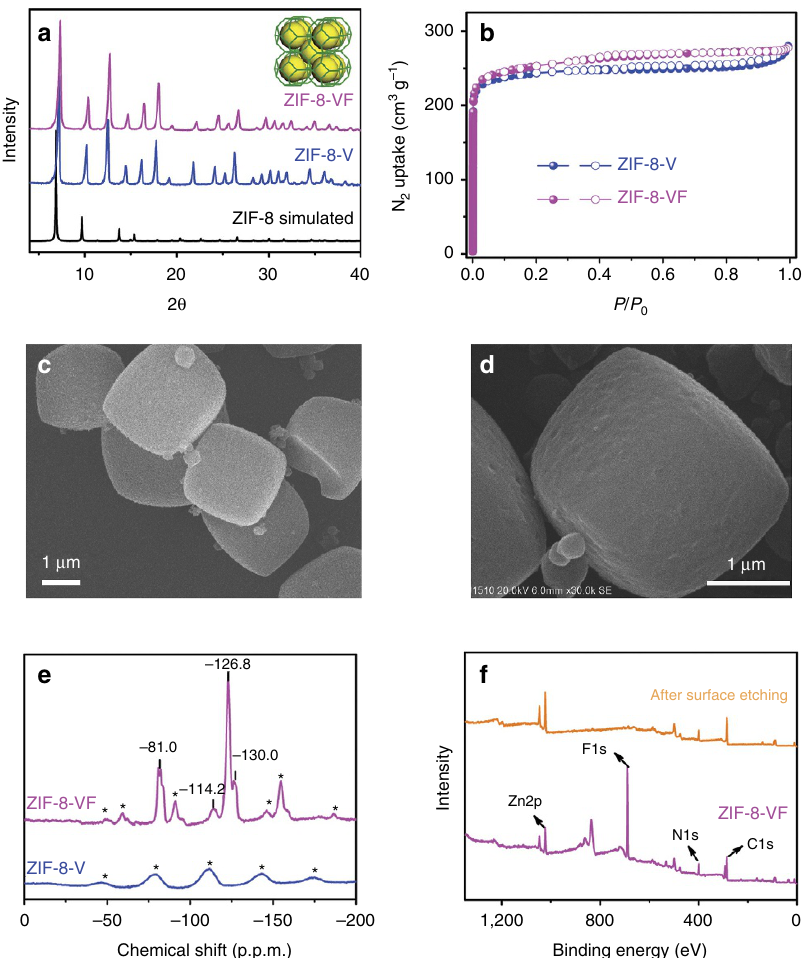
Figure 3 | Structural characterization. ( a ) PXRD patterns, ( b ) N 2 sorption isotherms measured at 77K, ( c ) SEM image of ZIF-8-V, ( d ) SEM image of ZIF-8-VF, ( e ) 19 F MAS NMR curves and ( f ) X-ray photoemission spectra of ZIF-8-VF before and after surface Ar þ ions etching (*side